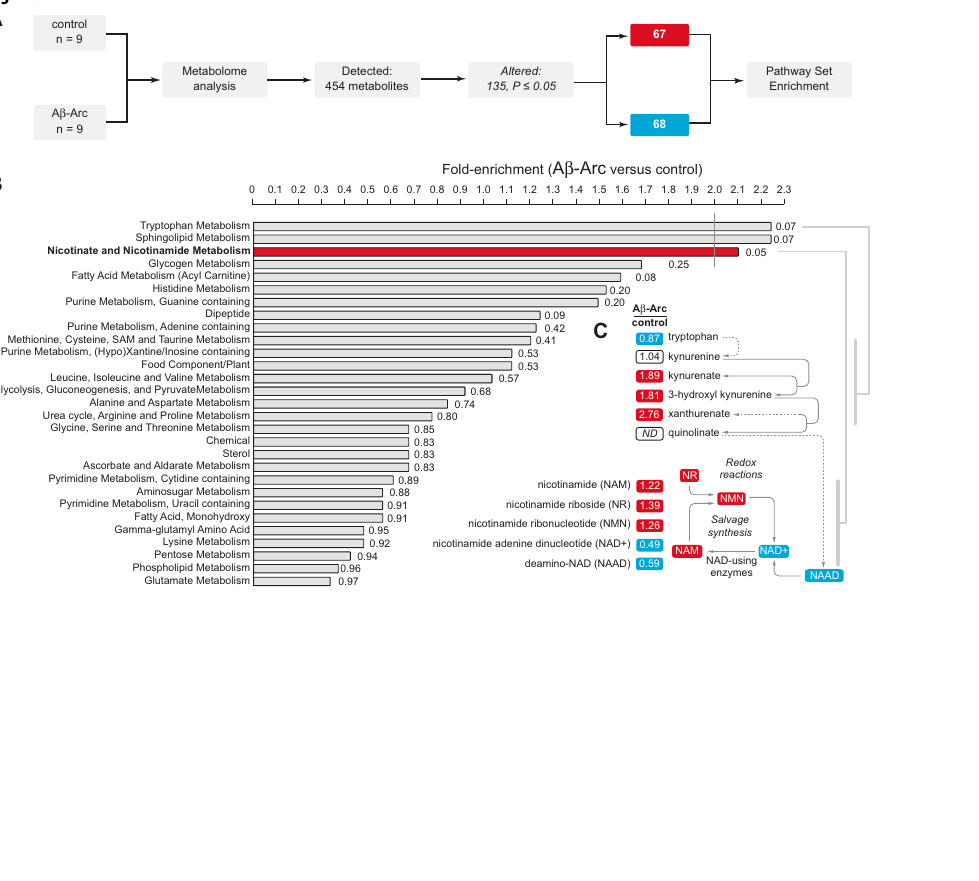
Fold-enrichment ( A β -Arc versus control)